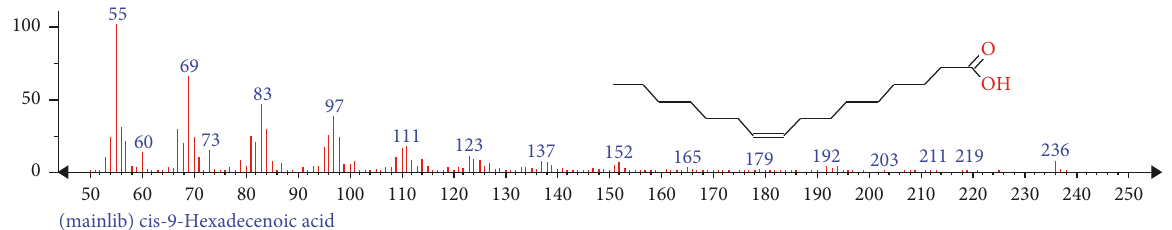
Figure 32: Mass spectrum of compound cis-9-hexadecenoic acid of whole plant hexane fraction of Achillea wilhelmsii (WHFAW).